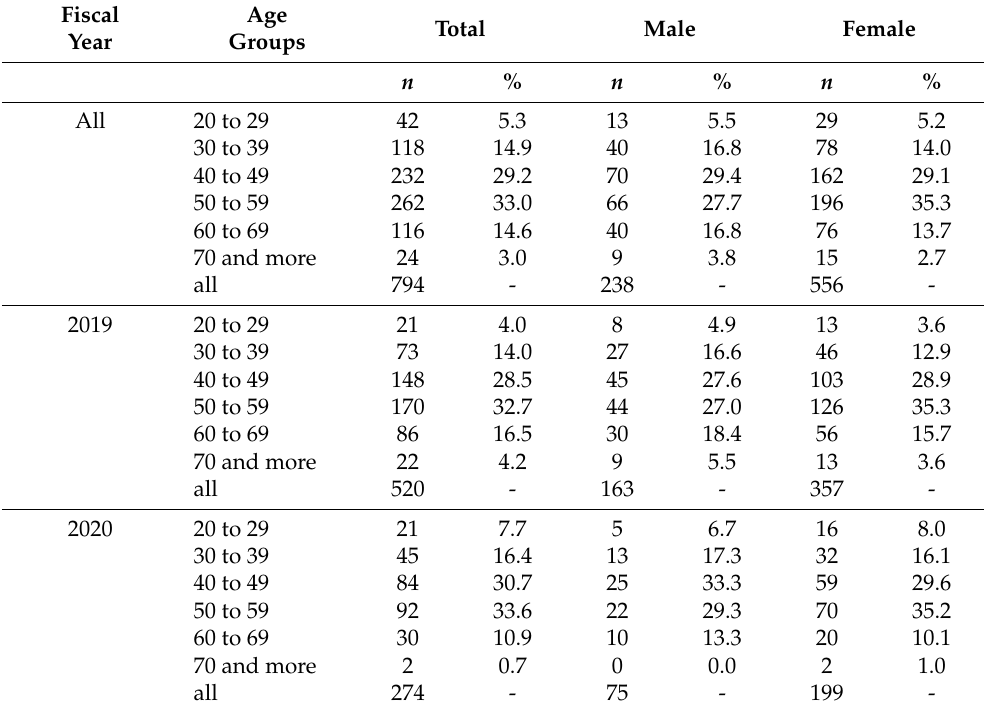
Table 1. Characteristics of participants in this